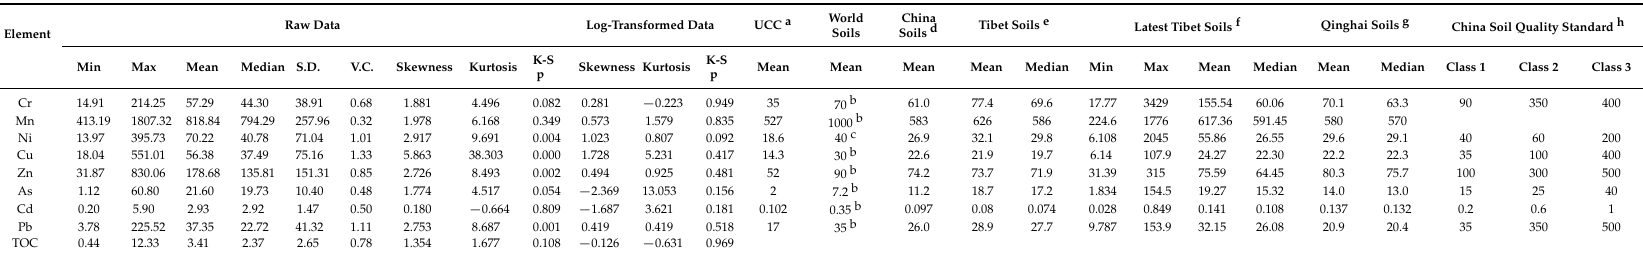
Table 1. Basic descriptive statistics of the HM concentrations of surface soils in the upper reaches of the Heihe River and comparisons with various studies (mg/kg;